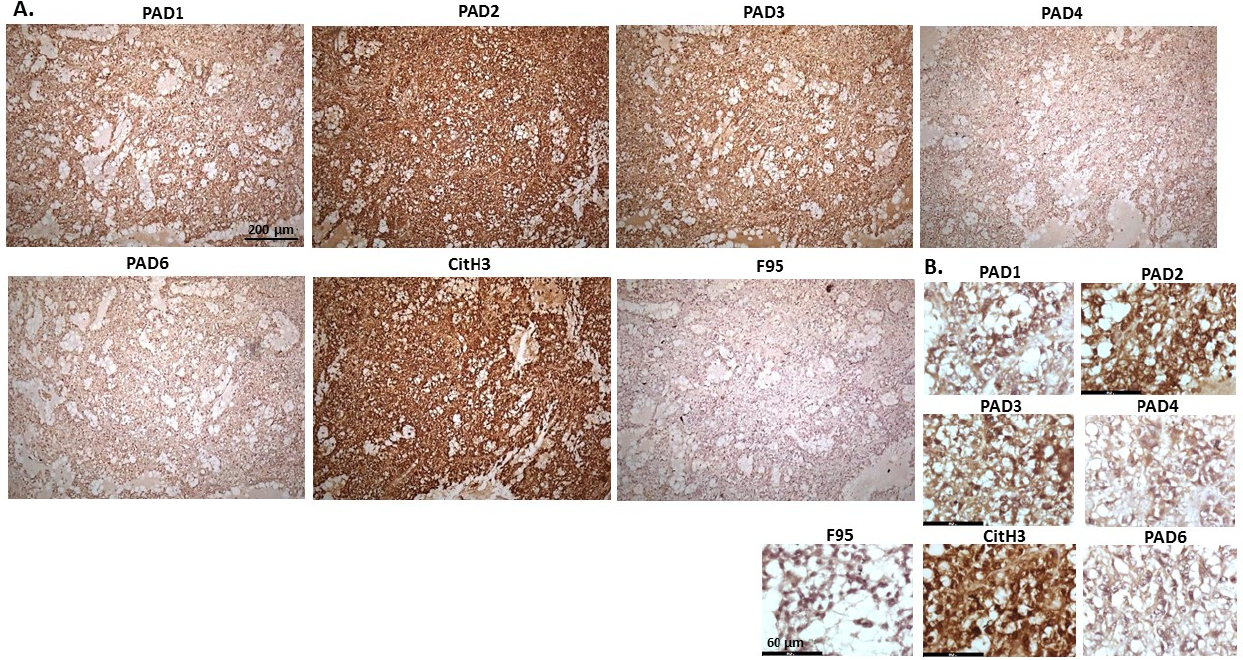
Figure 11. Dog Granulosa cell tumour, ovary; Samples from ovary of a five-year-old bitch. ( A ) Overview images for PAD1, 2, 3, 4, 6, CitH3, and F95 stainings of serial tissue sections; scale bar represents 200 μ m for all images; 10× objective. ( B ) Higher magnification shown for each staining from the images in ( A ); scale bar represents 60 μ m for all images; 40× objective.